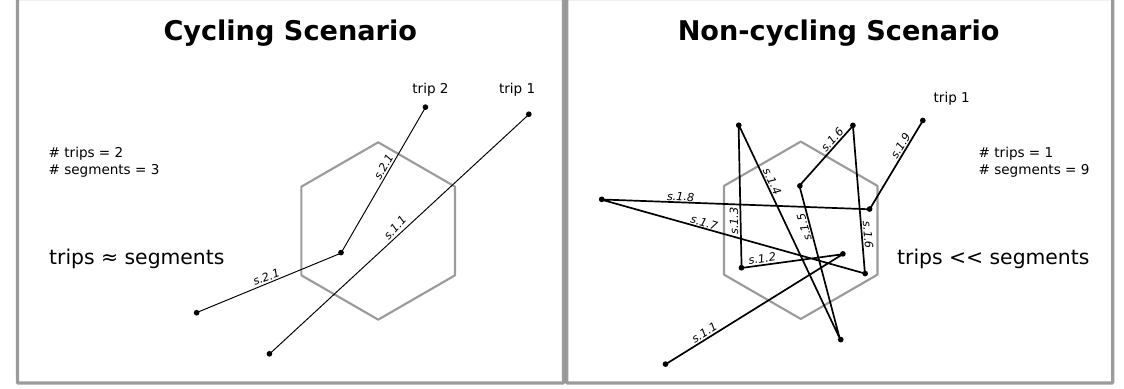
Figure 2. Trip and trips segments at a grid cell, two